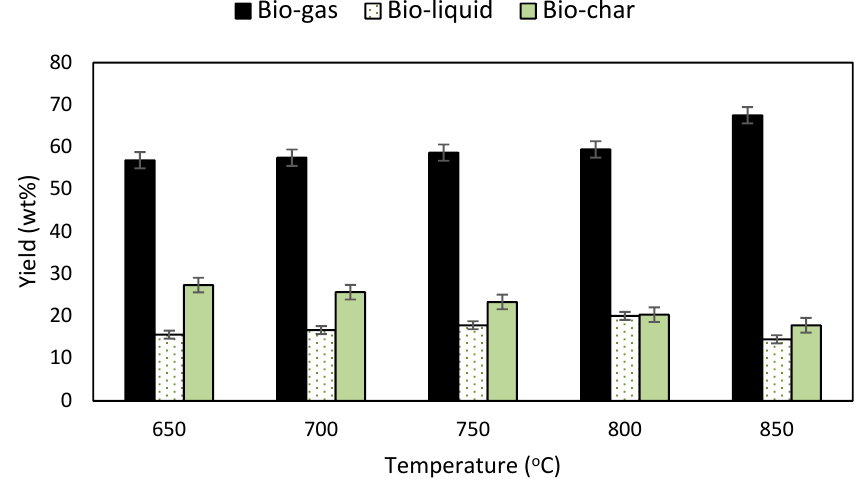
Figure 5. E ff ects of temperature on Napier grass gasification Figure 5. Effects of temperature on Napier grass gasification yield.